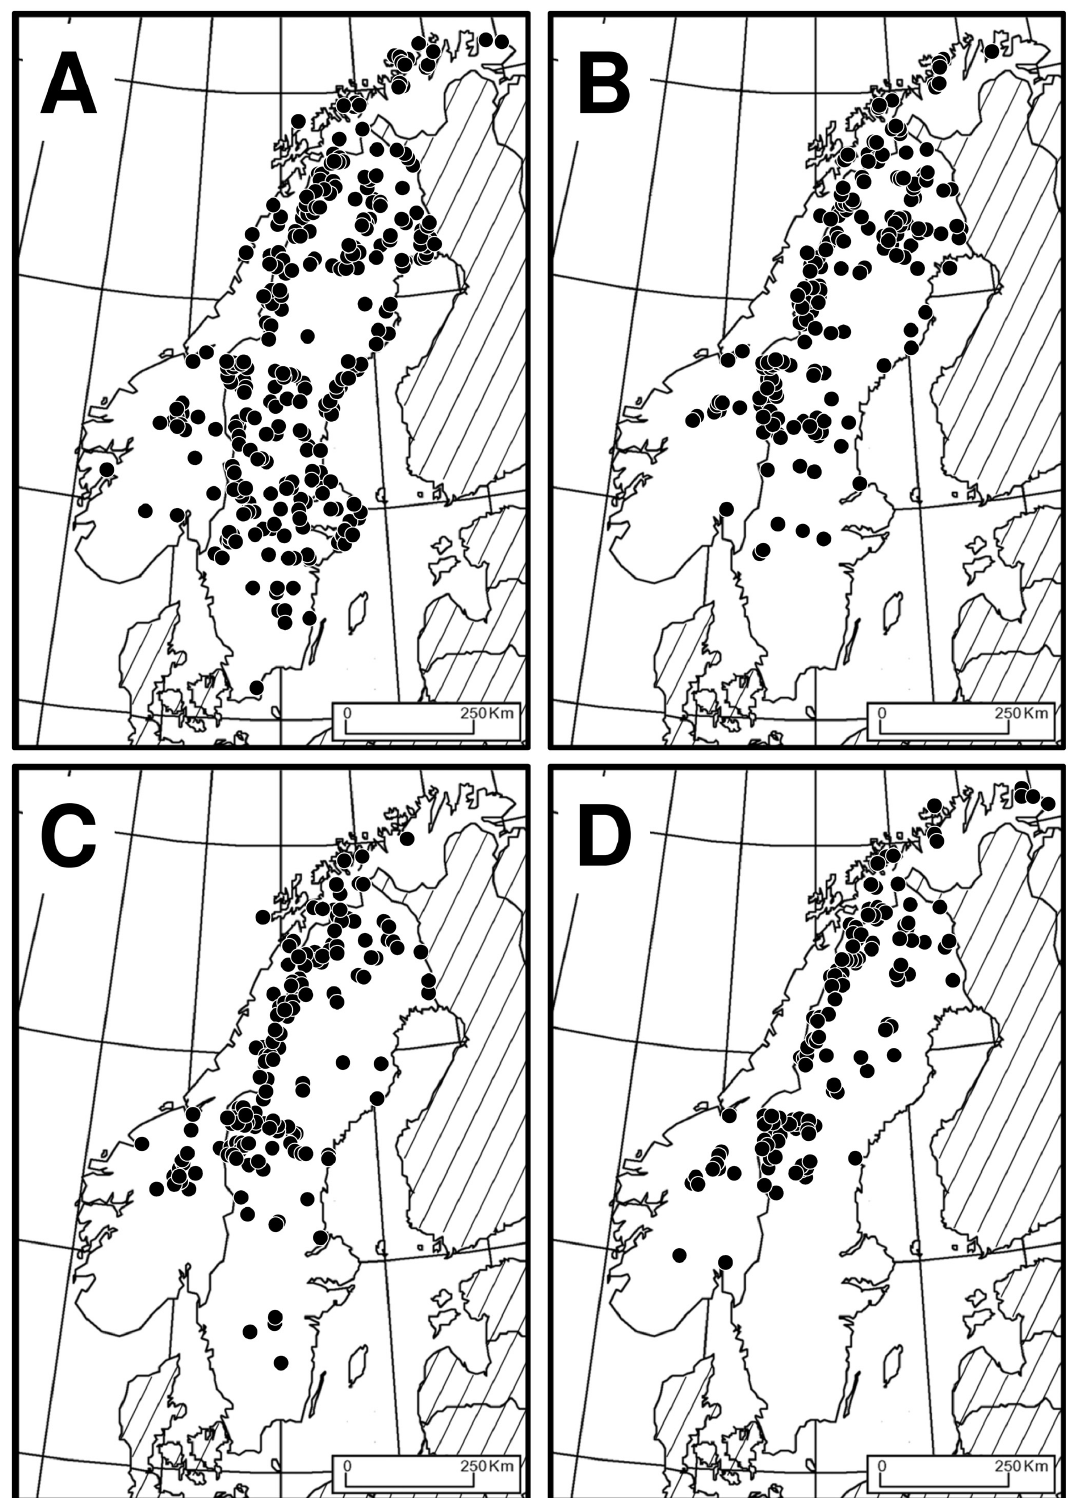
Fig. 3. Geographical distributions in Scandinavia. A . Oncophorus elongatus (n = 459). B . O. wahlenbergii (n = 333). C . O. virens (n = 361). D . O. integerrimus Hedenäs sp. nov. (n = 247). The distribution maps are based on the S material for which geographical origin could be